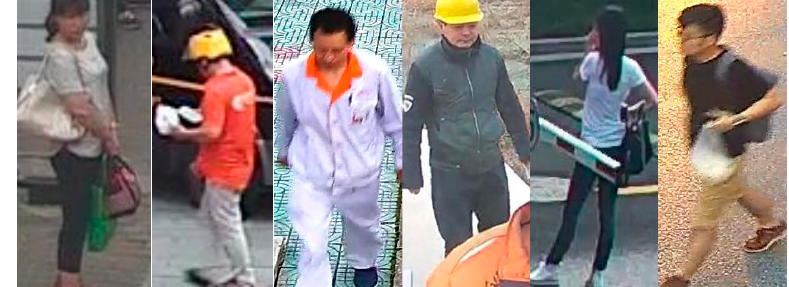
Figure 1. Pedestrian property sample diagram.